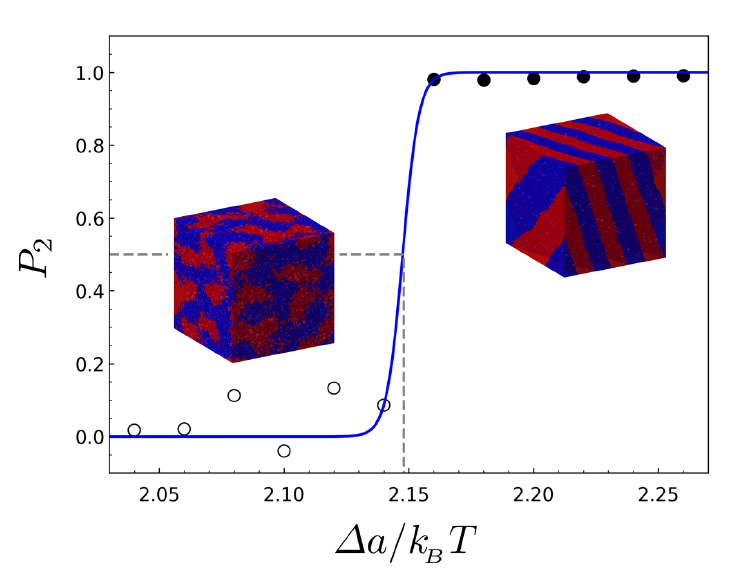
Figure 2. The order parameter versus the interaction parameter for the BBC having the architectural parameters of { M = 8, N = 14, λ = 2/13 } . The open circles and filled circles represent the points where the disordered and the ordered phases are stable, respectively, and the blue solid line is fit to a three-parameter sigmoidal function. The inset images show the two example structures simulated at the disordered and ordered